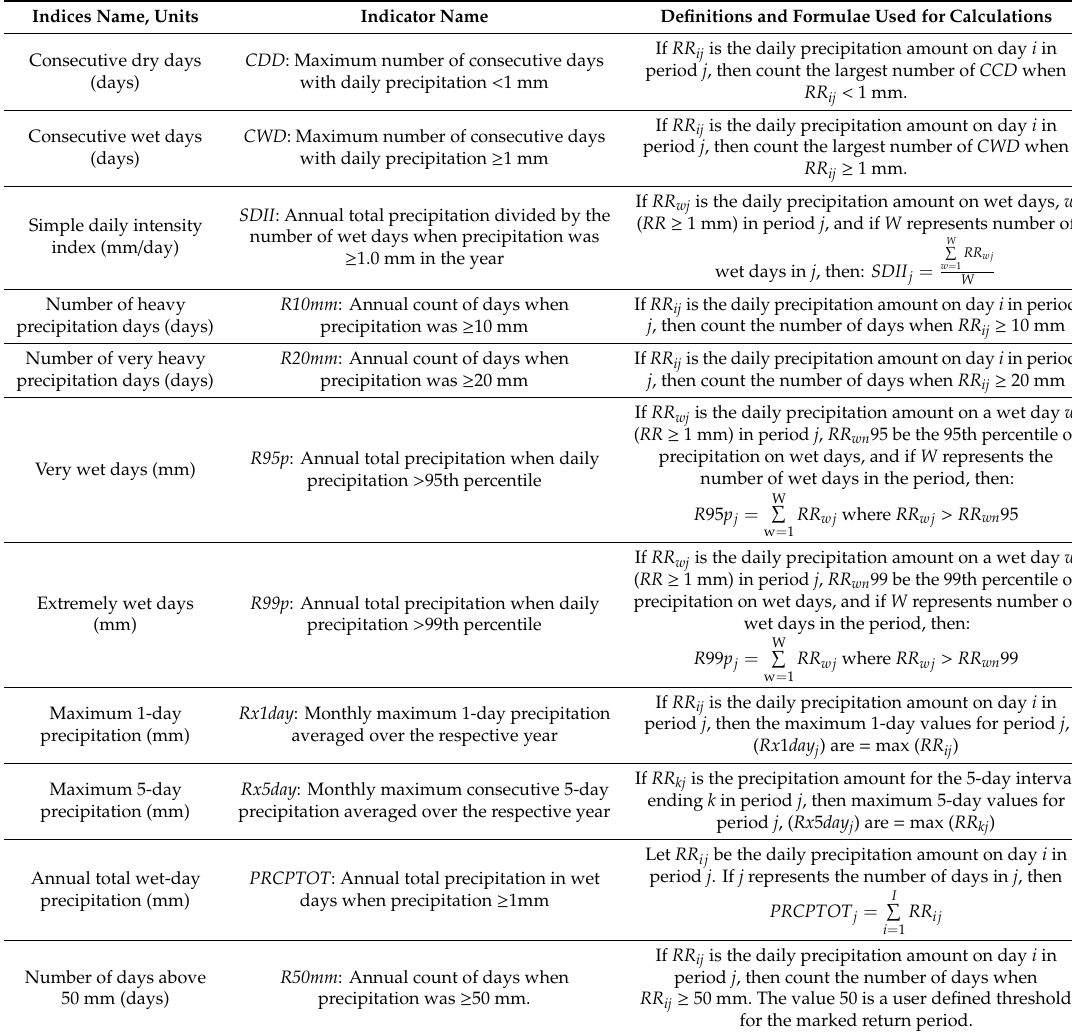
Table 3. The precipitation extreme indices calculated for the selected